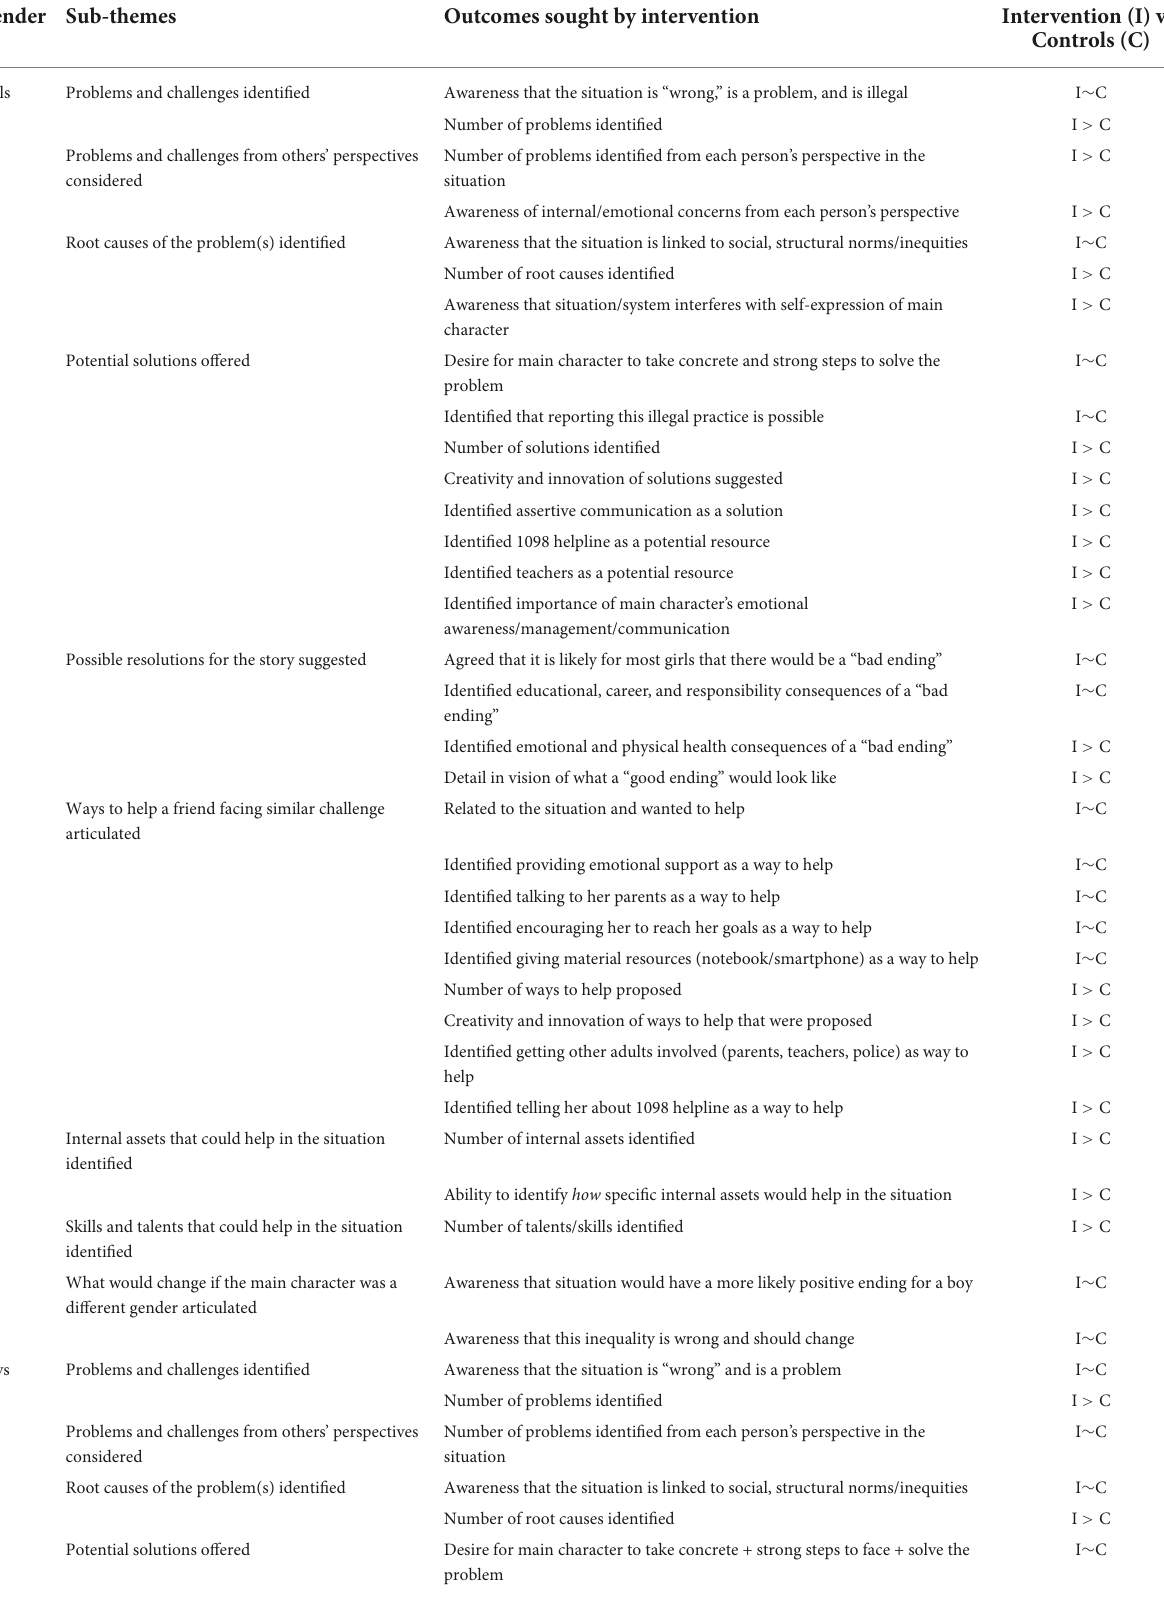
TABLE 4 Intervention vs. controls by outcomes arising from focus groups. Gender Sub-themes Outcomes sought by intervention Intervention (I) vs.